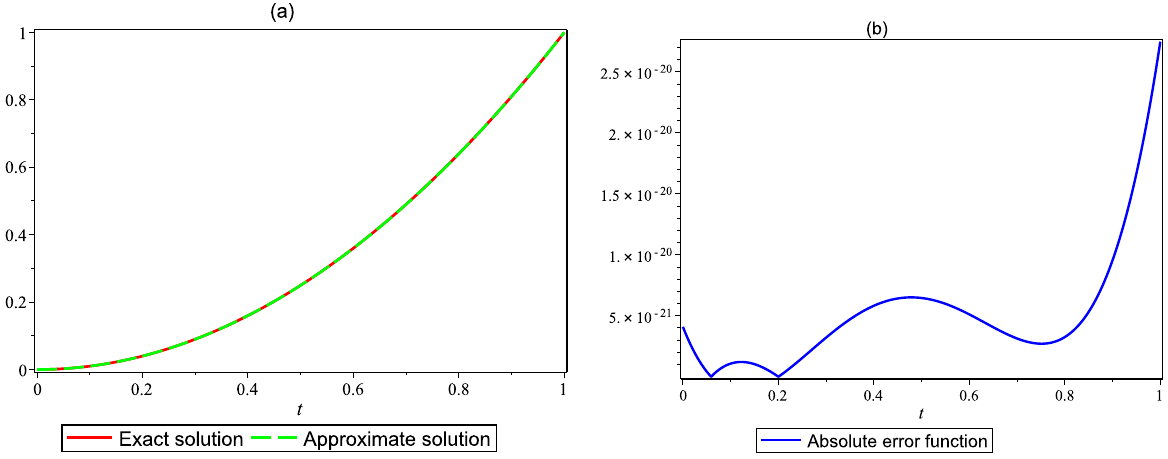
Figure 7. ( a ) Exact and approximate solutions, ( b ) absolute error function for N = 5, η = 1 for Example 4.